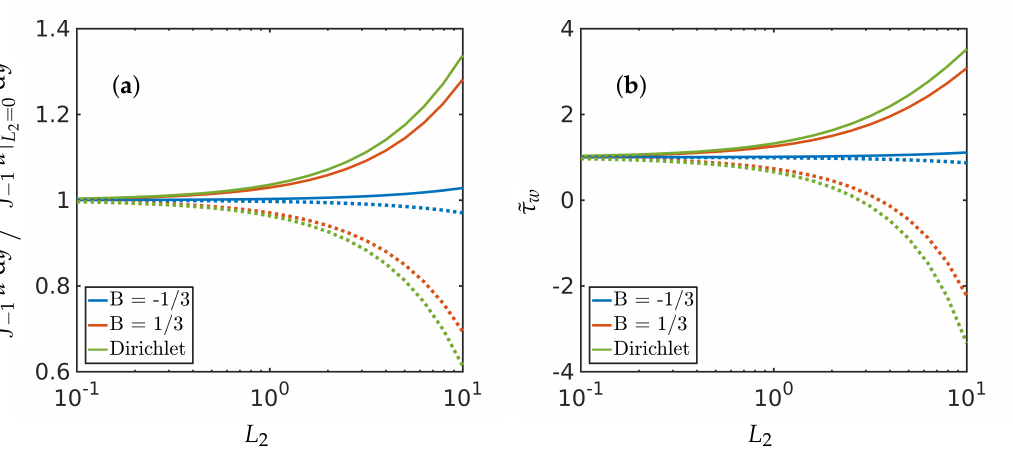
Figure 4. Plot of ( a ) the total volumetric flow rate and ( b ) the wall shear stress (which relates to the skin friction coefficient through Equation (25)) as a function of L 2 for different values of the constant B in the symmetric (Dirichlet) case, Equation (15), and the asymmetric case, Equation (16), for θ . The total flow rate is scaled with the equivalent Poiseuille flow rate for a Newtonian fluid, The solid and the dotted lines correspond to the negative and positive values of ˜ p x